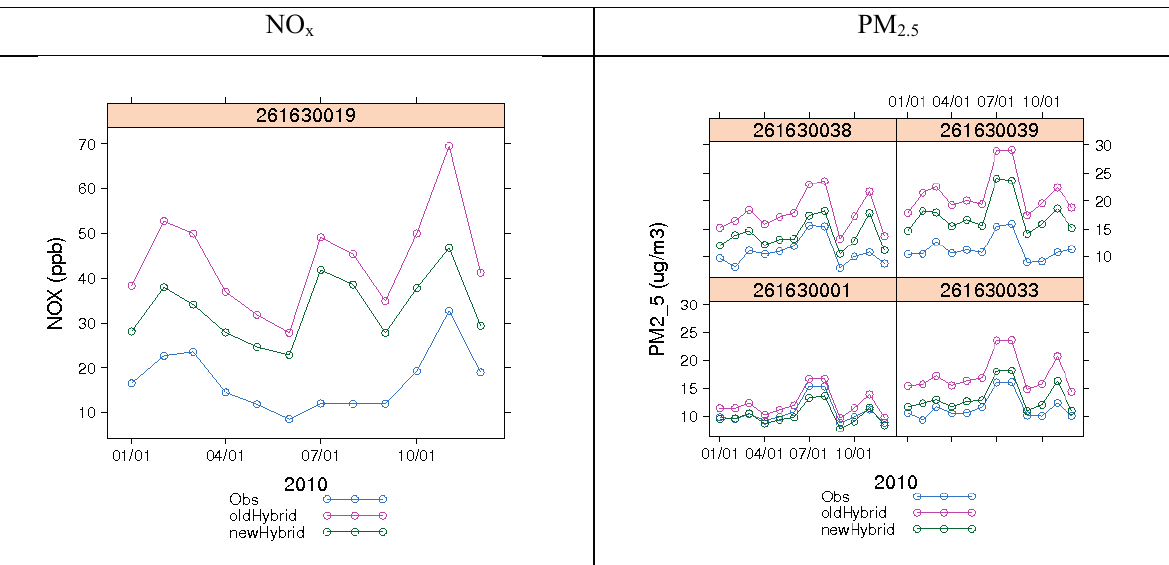
Figure 11. Time series plots showing monthly averaged observed concentrations paired spatially and temporally against hybrid estimates from the two STOK methods, one using were either soft or hard depending on the classification as background or not ( new hybrid